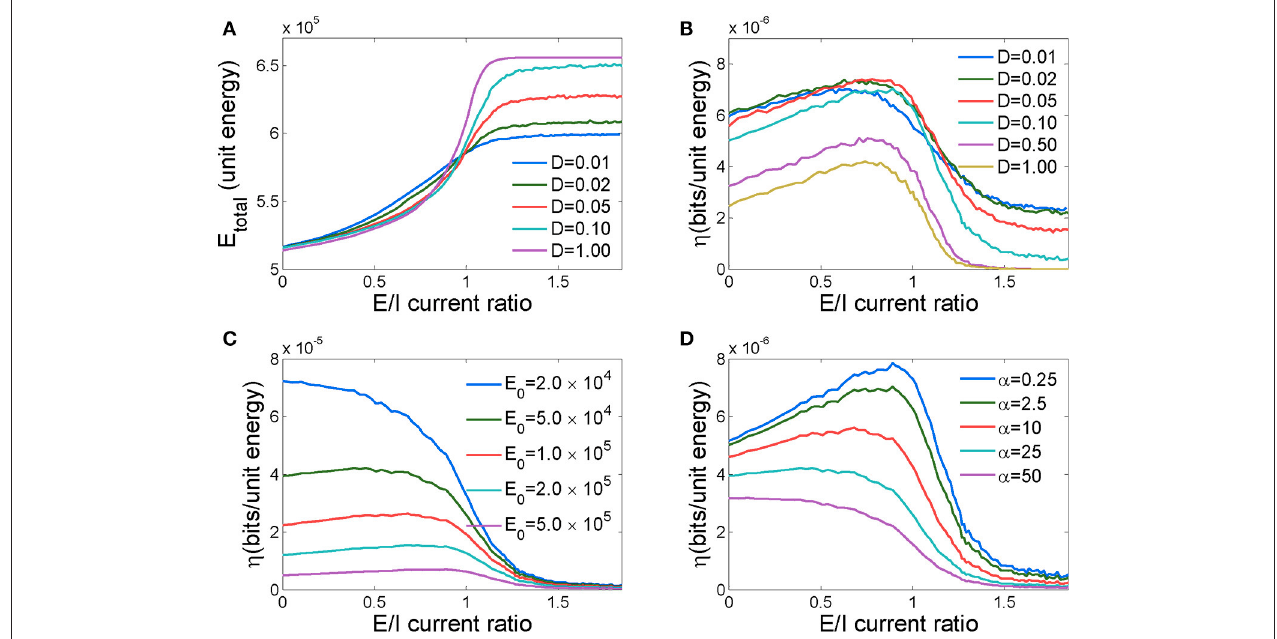
FIGURE 5 | The effects of the E/I current ratio on the energy cost and energy efficiency of a neuronal network. (A) The total energy cost as a function of the E/I current ratio for different noise intensities. (B) The energy efficiency as a function of the E/I current ratio for different noise intensities. (C) The energy efficiency as a function of the E/I current ratio for different fixed energy costs. (D) The energy efficiency as a function of the E/I current ratio for different energy costs per synaptic event. In C , D , the noise intensity D 0.1, and N 250 in all = =